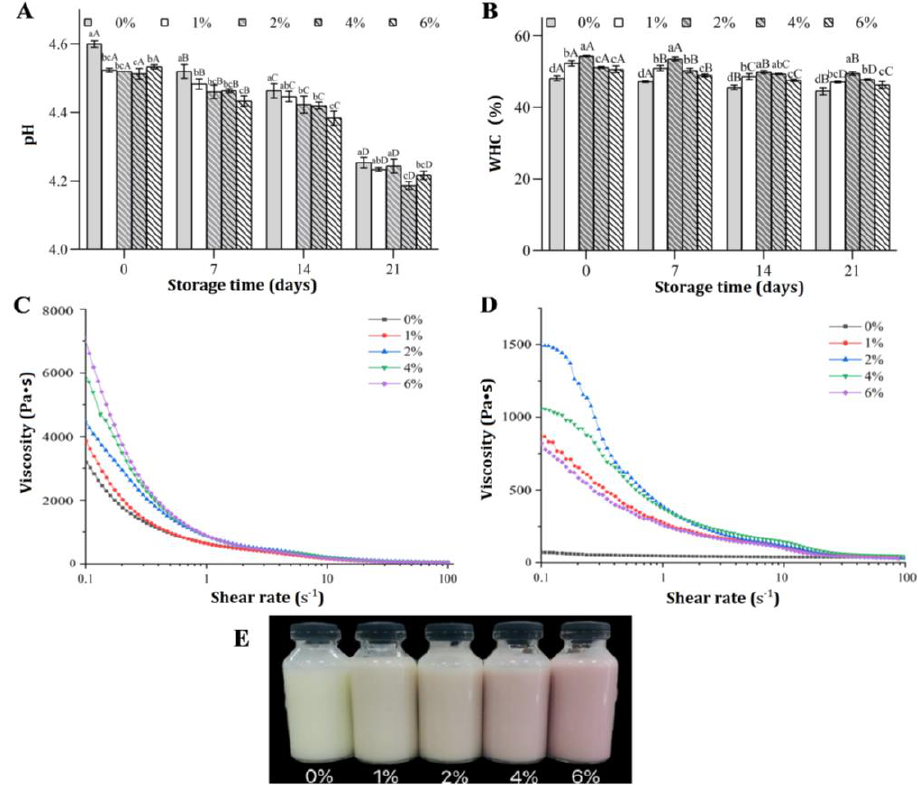
Figure 1. Physicochemical properties of fermented goat milk as affected by various blue honeysuckle juice concentration. ( A ) pH value; ( B ) water-holding capacity; ( C ) viscosity on day 0 and ( D ) after 21 days of storage at 4 °C; ( E ) visual appearance. Note: Different lowercase letters denote significant differences ( p < 0.05) between different concentrations of blue honeysuckle juice on the same day; different uppercase letters denote significant differences ( p < 0.05) between different storage times at the same levels of blue honeysuckle juice concentrations.